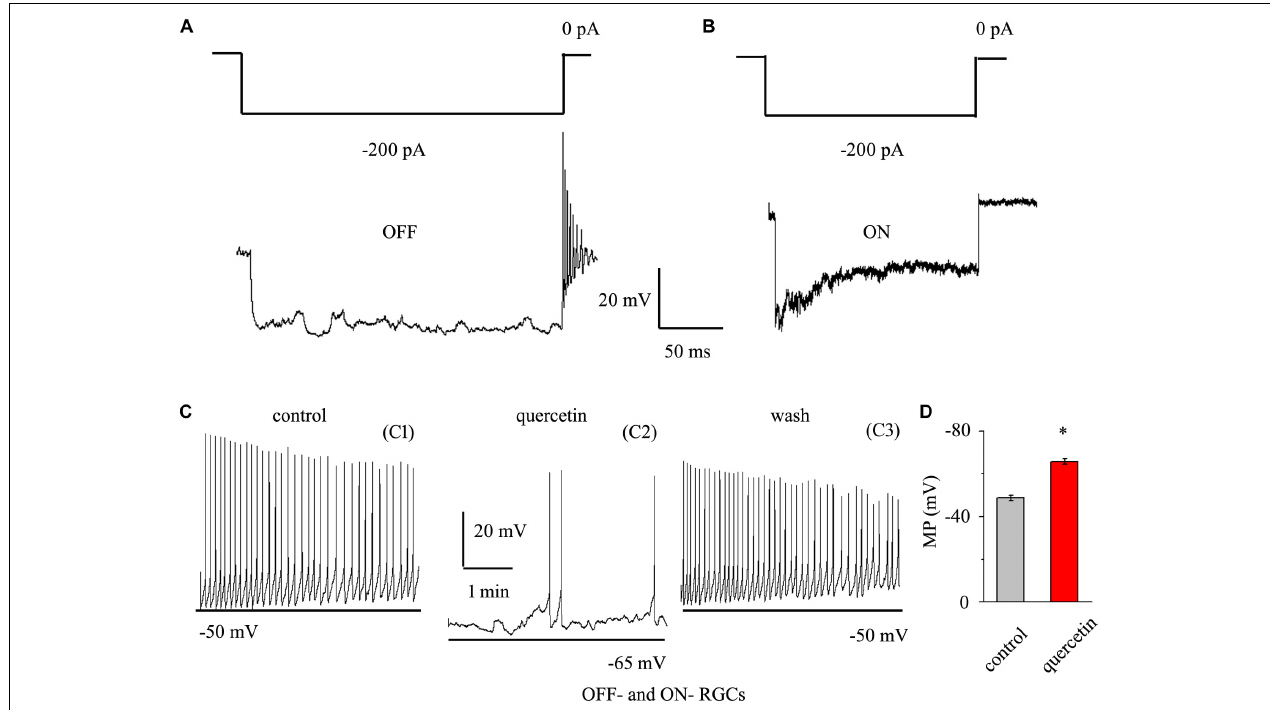
FIGURE 8 | Quercetin hyperpolarized RGCs and decreased the firing rate. (A,B) Top trace: responses to a –200 pA current step in OFF-type RGCs (A) and ON-type RGCs (B) . Negative current injection led to rebound burst firing in OFF-type RGCs but not in ON-type RGCs. Vertical bar, 20 mV; horizontal bar, 50 ms. (C) Current clamp recording of a representative RGC. Note that quercetin caused hyperpolarization and decreased the firing rate. Recordings under control conditions (C1), during application of quercetin (C2), and during washout (C3) are shown on an expanded time scale. (D) Bar graph summarizing the changes in MP. Quercetin can hyperpolarize MP. MP, membrane potential. ∗ p < 0.05, paired Student’s t